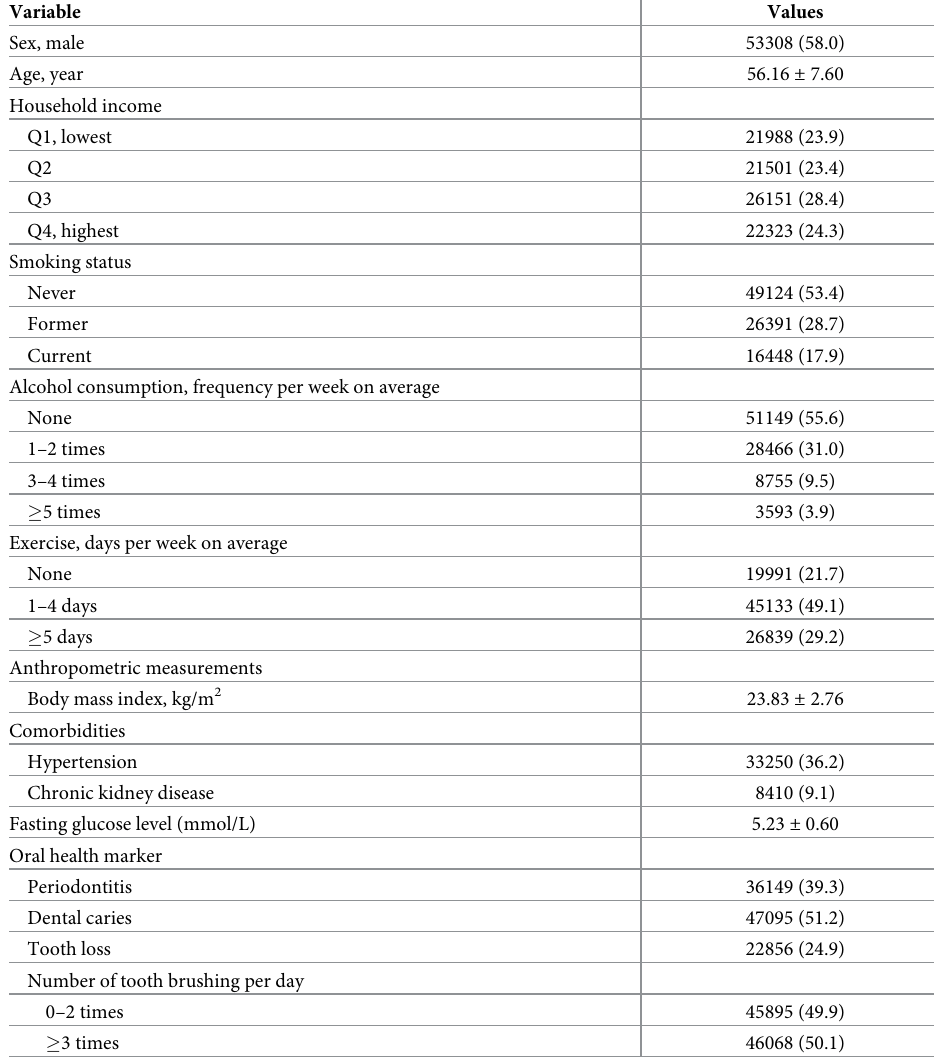
Table 1. Clinical characteristics of the study participants at the baseline health